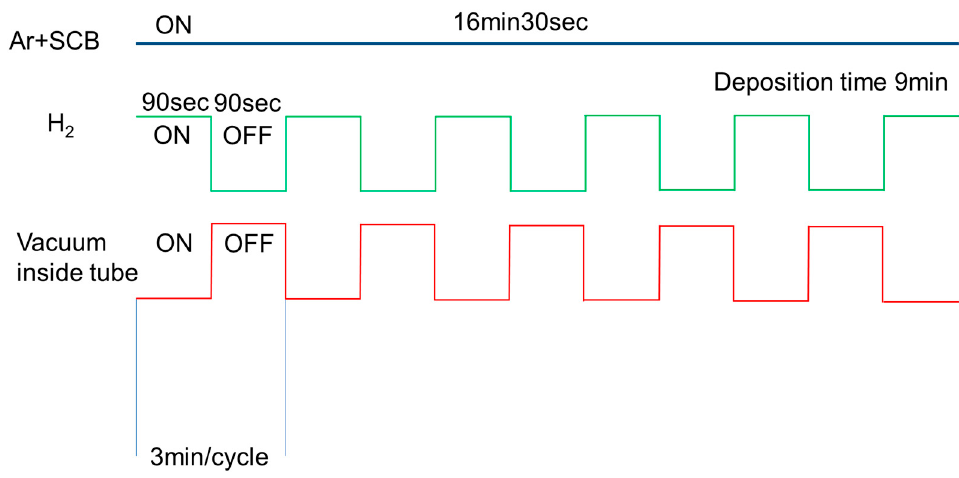
Figure 3. Pattern of source gas supply, reaction gas supply, and vacuum inside tube.